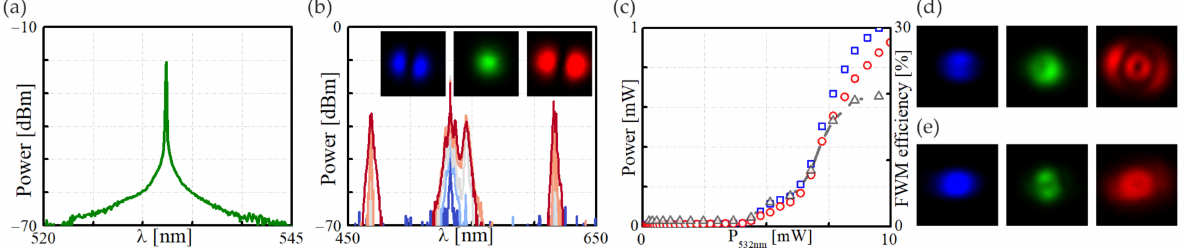
Figure 4. The four-wave mixing process in a 0.8 m, stress-free FUT. Spectral characteristics: ( a ) the pump beam ( p = 0.1 mW and λ = 532 nm) and ( b ) the optical output field (plotted for the pump beam powers of 0.5 mW, 4.0 mW, 5.0 mW, 6.0 mWb and 9.0 mW–dark blue to solid red lines). The insets present a modal field distribution of (from the left) an anti-Stokes, pump, and Stokes beam: ( c ) the power of Stokes (red circles) and anti-Stokes (blue squares) matched with the IM-FWM efficiency (gray triangles) as a function of the power of a pump beam; ( d , e ) the modal field distribution at the FUT’s output in the case of sub-optimal beam coupling: (from the left) the anti-Stokes, pump, and Stokes